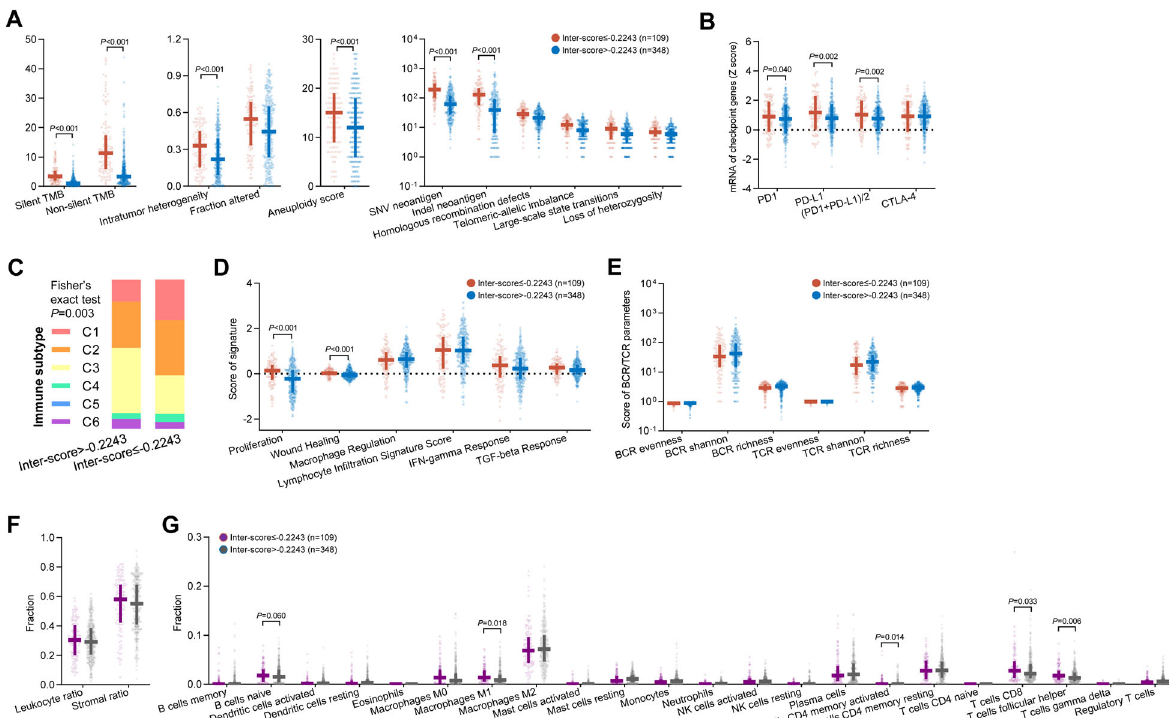
Fig. 4 Immune correlates of the inter-score in the TCGA-LUAD cohort. A – G Associations of the inter-score with TMB, intratumor heterogeneity, fraction altered, aneuploidy score, neoantigen load, homologous recombination defects ( A ), mRNA of immune checkpoint genes ( B ), immune subtype ( C ), signatures supporting immune subtyping ( D ), and BCR/TCR parameters ( E ), leukocyte/stromal ratio ( F ), and tumor-in fi ltrating immune cells ( G ). Abbreviations: BCR B cell receptor, LUAD lung adenocarcinoma, SNV single-nucleotide variation, TCGAThe Cancer Genomic Atlas, TCR T cell receptor, TMB tumor mutational